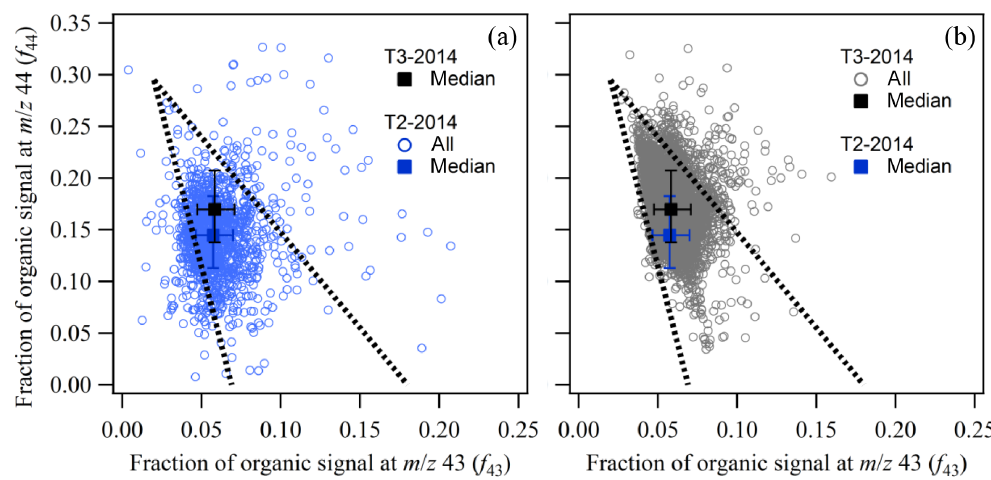
Figure 3. Scatterplot of the AMS signal fraction at m/z 44 ( f 44 ) against that at m/z 43 ( f 43 ). Gray and blue circles correspond to measure- ments at T3 and T2 during IOP1, respectively, in the wet season of 2014. For visualization purposes, the two datasets are plotted separately in panels (a) and (b) . Solid squares represent median values, and whiskers represent 10 and 90 percentiles. Dashed lines delineate the region where worldwide measurements of ambient organic PM 1 commonly lie (Ng et al.,